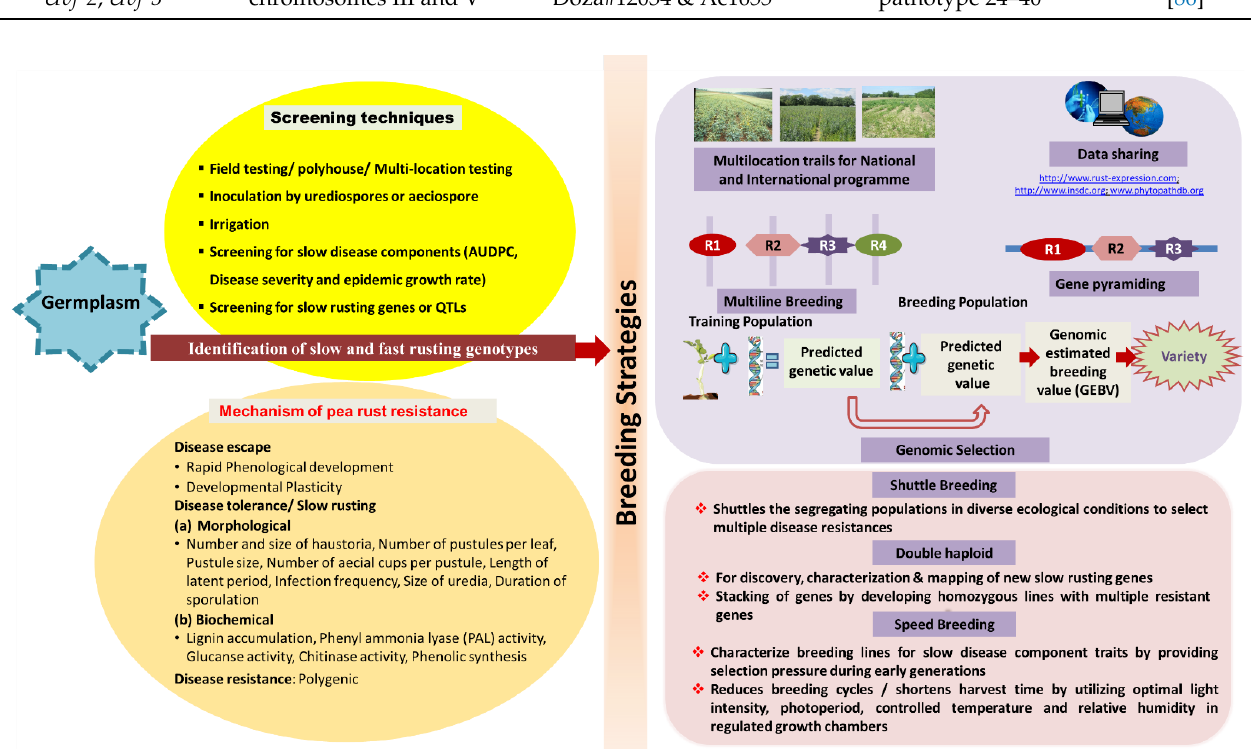
Figure 7. Outline of screening technique, mechanism of resistance, and breeding for rust-resistant pea